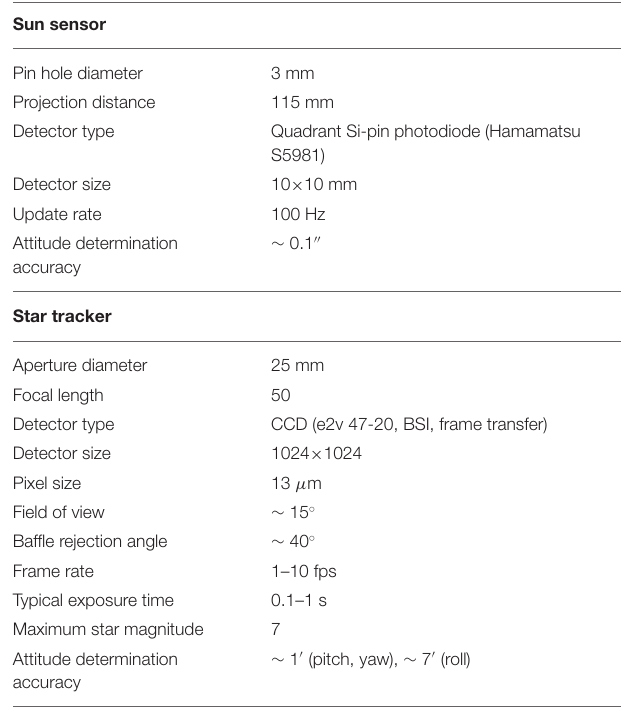
TABLE 8 | Main characteristics of attitude control